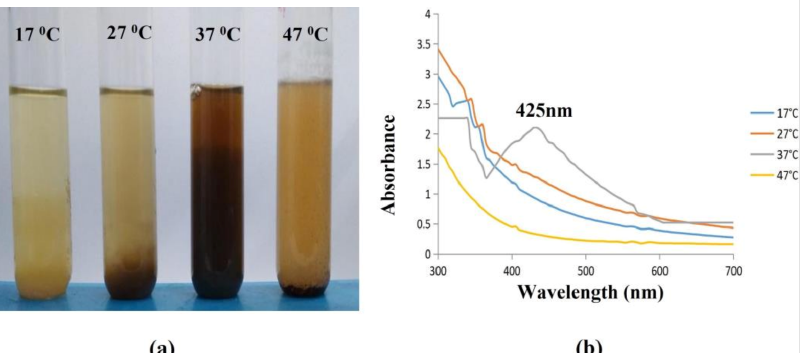
Figure 8. Effect of Temperature on synthesised AgNPs. ( a ) Darkening of color indicating the synthesis of AgNPs was observed at 37 ◦ C. ( b ) The synthesis of AgNPs (37 ◦ C) was confirmed with a spectral peak at 425 nm using a UV-Vis Spectrophotometer.